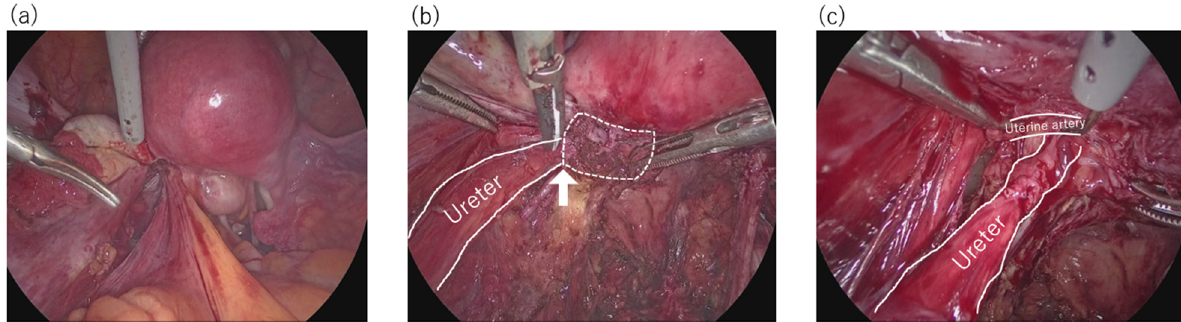
Figure 2. ( a ) The rectum adhered to the posterior wall of the uterus, and the pouch of Douglas was completely closed. ( b ) The ureter was entrapped in the DE around the left sacrouterine ligament. ( c ) When the ureter was detached from the DE, the ureter was completely opened.